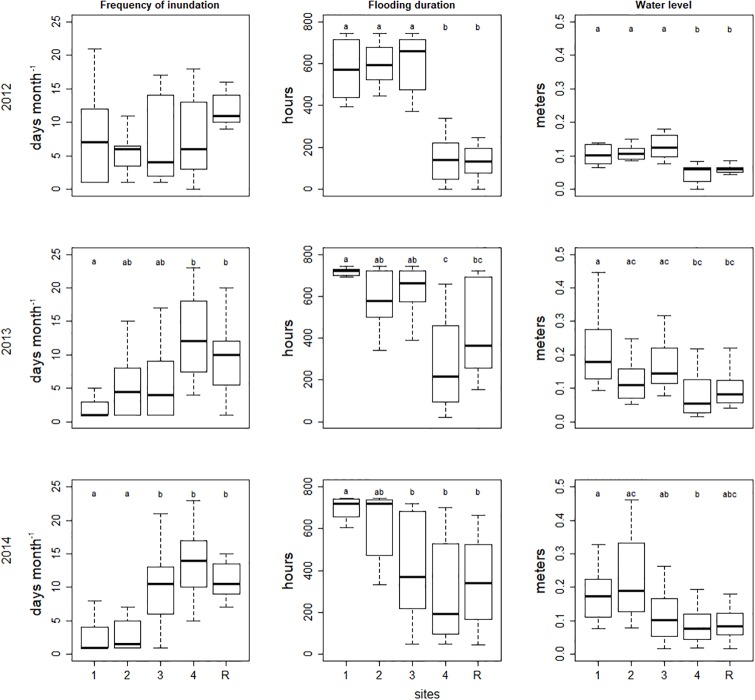
Box plots indicating hydroperiod patterns (flood duration, frequency, and level) in three consecutive years after implementation of restoration activities in impaired mangrove areas in Laguna de Términos, Campeche, Mexico.The boxplot represent the 25 to 75 percentiles (interquartile range) and the maximum—minimum distributions if the data, respectively. The line in the box is the median.